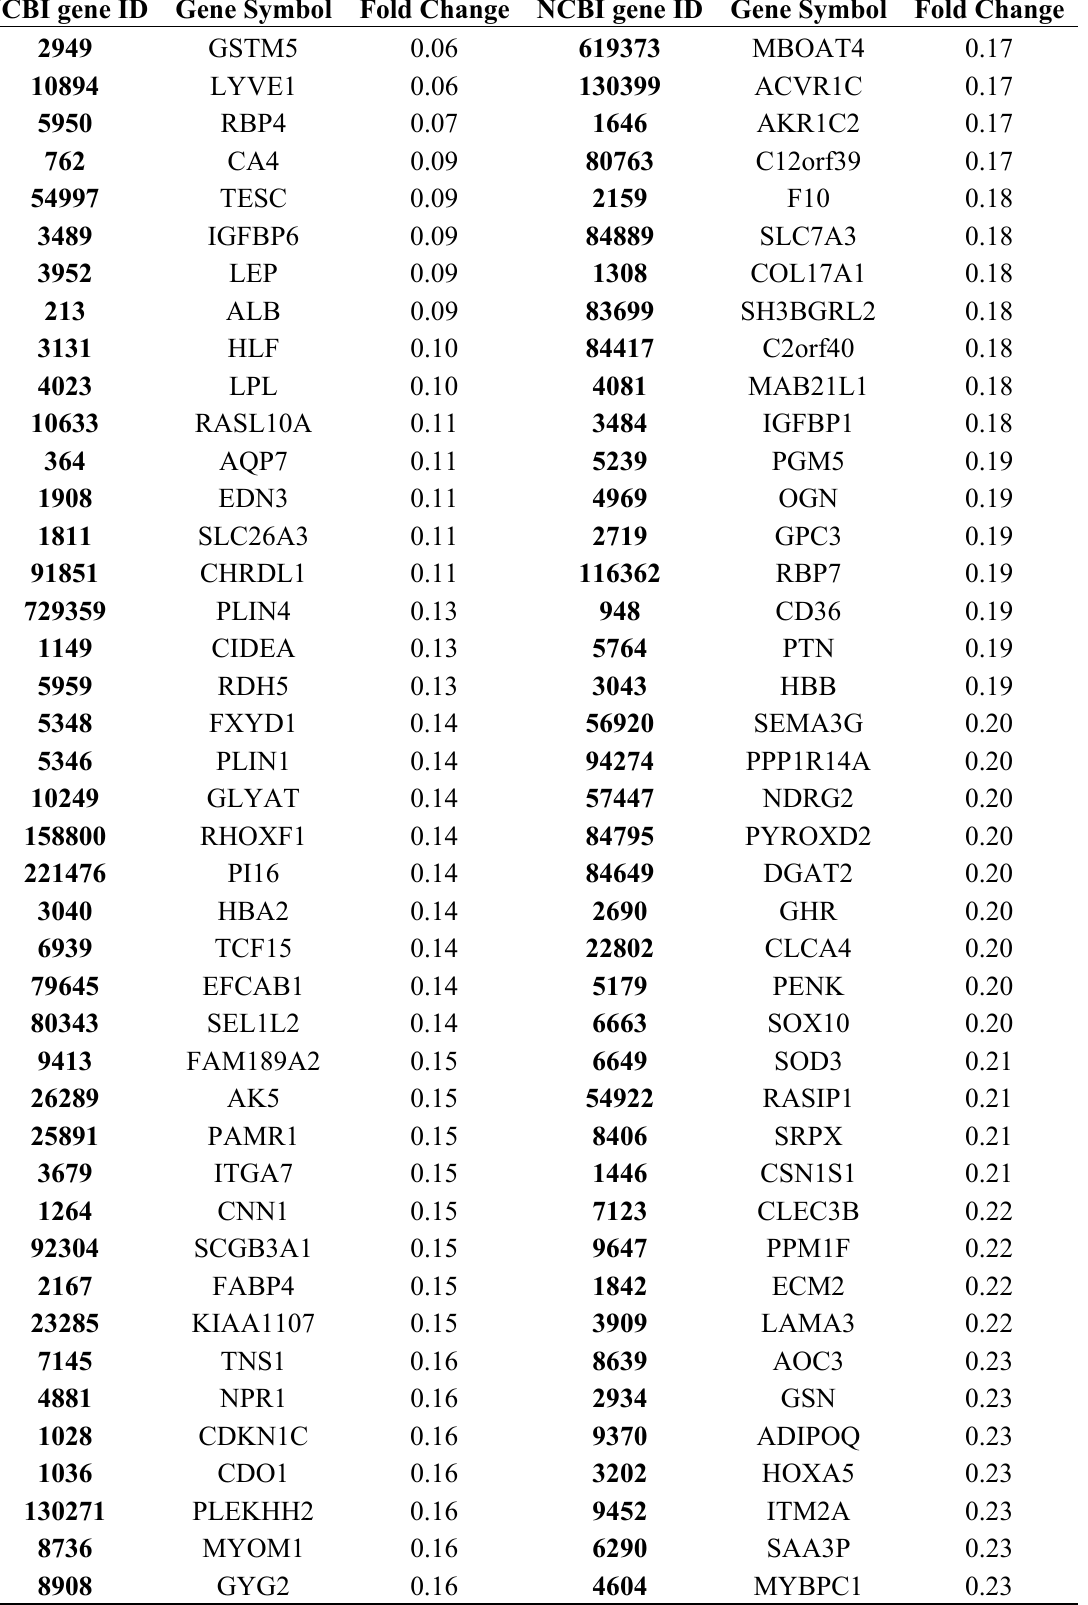
Table S2. Down-regulated genes found in dataset GSE29174. There are 726 down-regulated genes in this list. Q -values reported by SAM were 0 for all genes in this